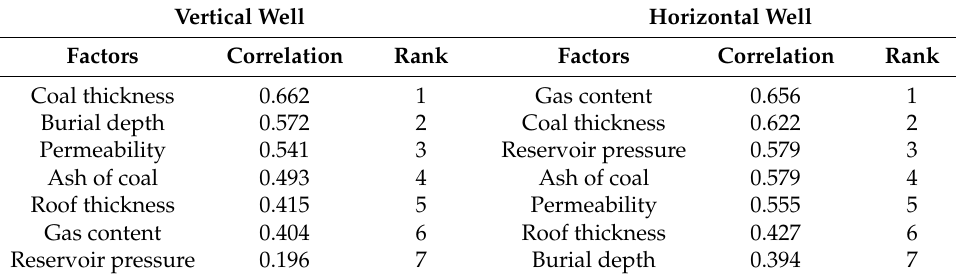
Table 5. Grey correlation quantitative evaluation of controlling factors of CBM production.